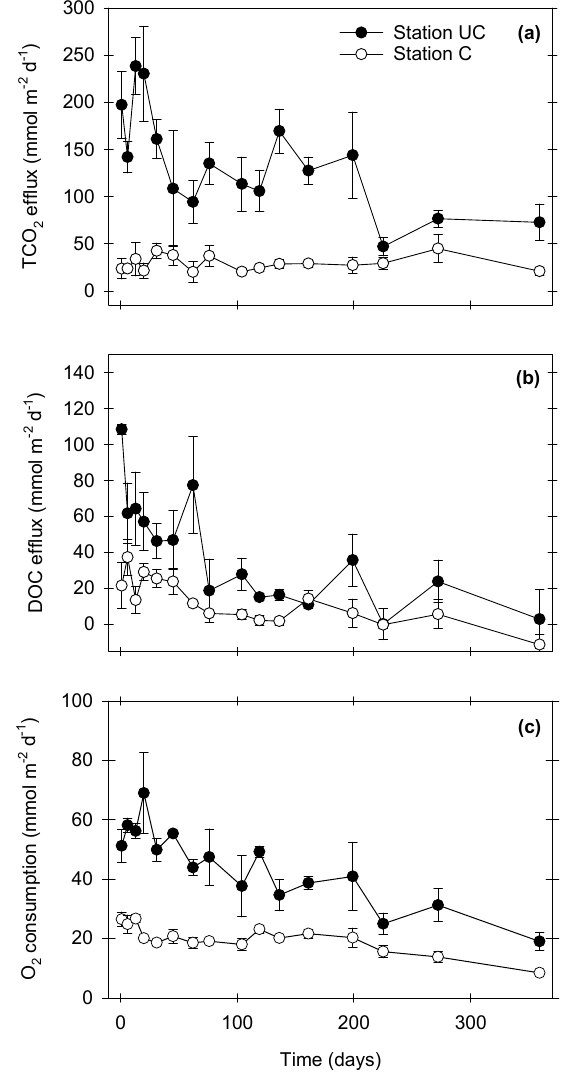
Figure 2. Fluxes of total carbon dioxide (TCO 2 , a ), dissolved or- ganic carbon (DOC, b ) and oxygen (O 2 ) consumption (c) in soil cores with uncultivated (UC) and cultivated (C) soil after flooding. Error bars indicate SEM ( n =